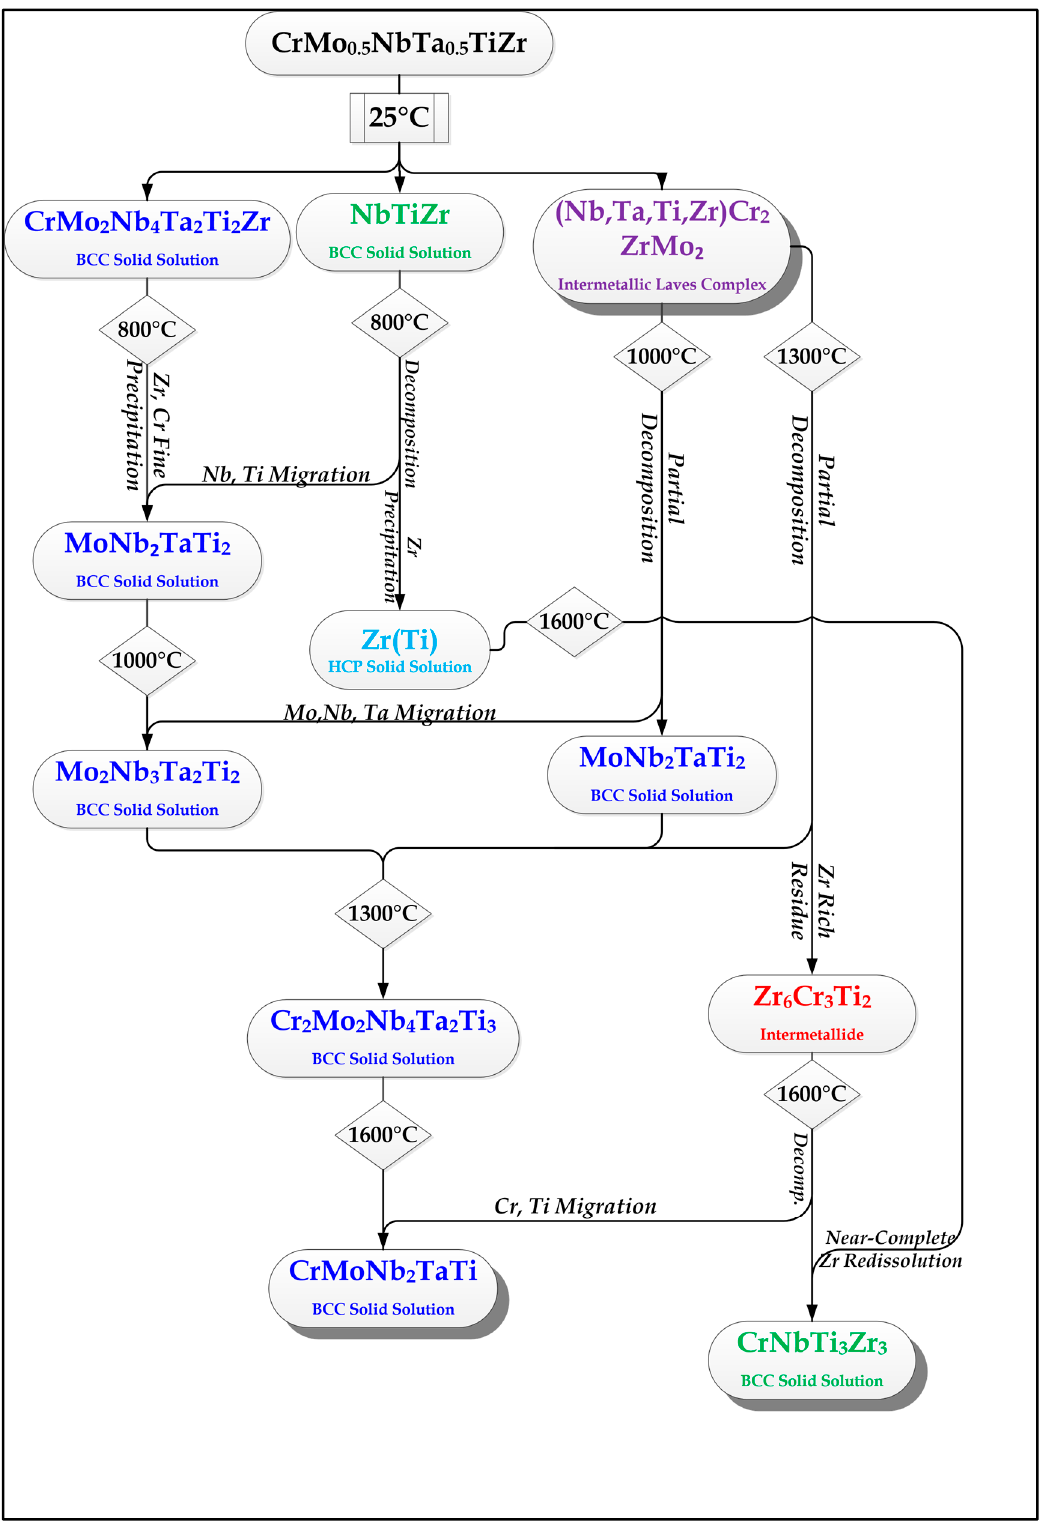
Figure 10 . Flowchart depicting the evolution of phases as the temperature rises in the Figure 10. Flowchart depicting the evolution of phases as the temperature rises in the Cr 20 Mo 10 Nb 20 Ta 10 Ti 20 Zr 20 alloy. Cr 20 Mo 10 Nb 20 Ta 10 Ti 20 Zr 20